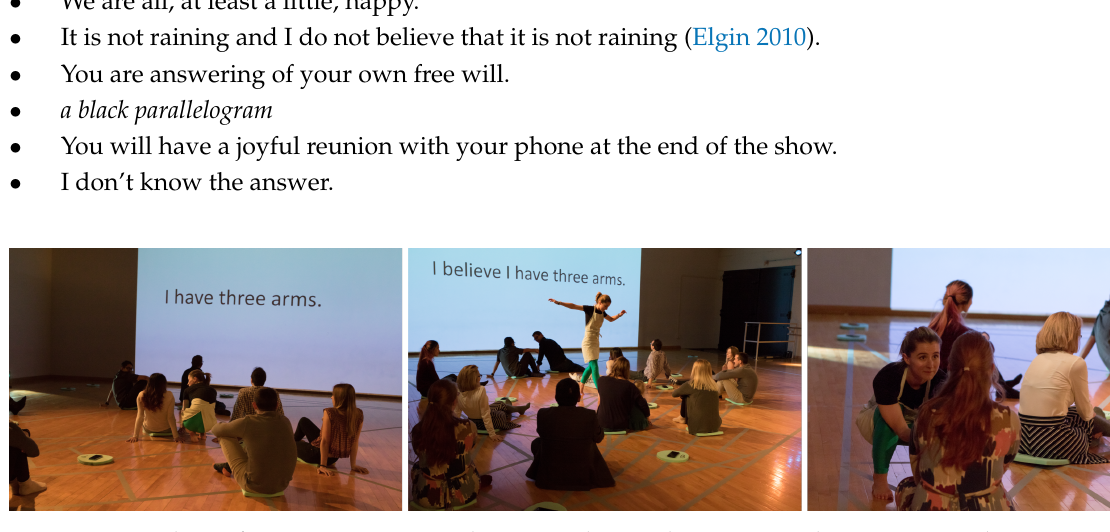
Figure 4. The performer questioning audience members with propositional statements. Each query takes on a unique tone—and often elicits answers loaded with quality that betray more than the requested “True” or “False” response. For example, “You will have a joyful reunion with your phone at the end of the show” may cause a dry, wry “False” or a sugary, sly “True”, betraying the simultaneous desire to be returned to expensive personal property and the antagonistic relationship many have with their distracting portals to the Internet. Photos by Natalie